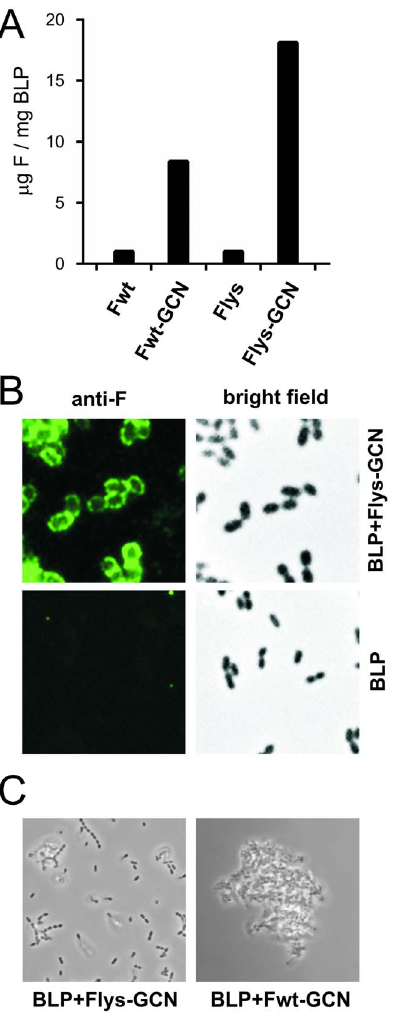
Figure 5. Binding of recombinant F proteins to BLPs. A) Binding efficacy of the various F proteins (Fwt, Fwt-GCN, Flys, and Flys-GCN; all carrying a C-terminal LysM domain, but no ST3 tag) to BLPs was determined by incubation of an equal amount (28 m g) of the F proteins with 1 mg of BLPs using standard conditions. The amount of F protein bound to the BLPs was determined by comparative SDS-PAGE analysis in which Colloidal Blue staining of F proteins was compared with that of BSA standards. B) To analyze the binding pattern of F to BLPs, BLPs carrying Flys-GCN with a LysM domain (BLP-F) were generated using standard conditions followed by incubation with Palivizumab and FITC- labeled goat-anti-human secondary antibodies. As a control ‘‘empty’’ BLPs were used. The preparations were analyzed using bright field and fluorescence microscopy. C) BLPs displaying Fwt-GCN or Flys-GCN were analyzed using bright field